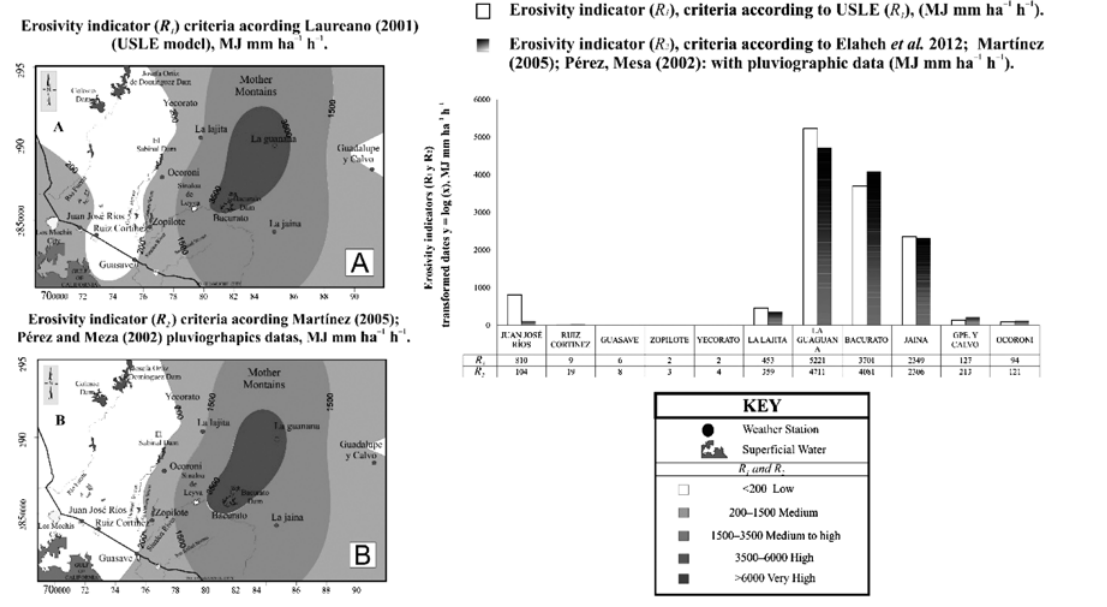
Fig. 3. (A) Spatial variation of annual average factors of rainfall erosivity according to USLE ( R factor of erosivity according to the curves of logarithmic regressions ( R ranges of risks for soils in northwestern